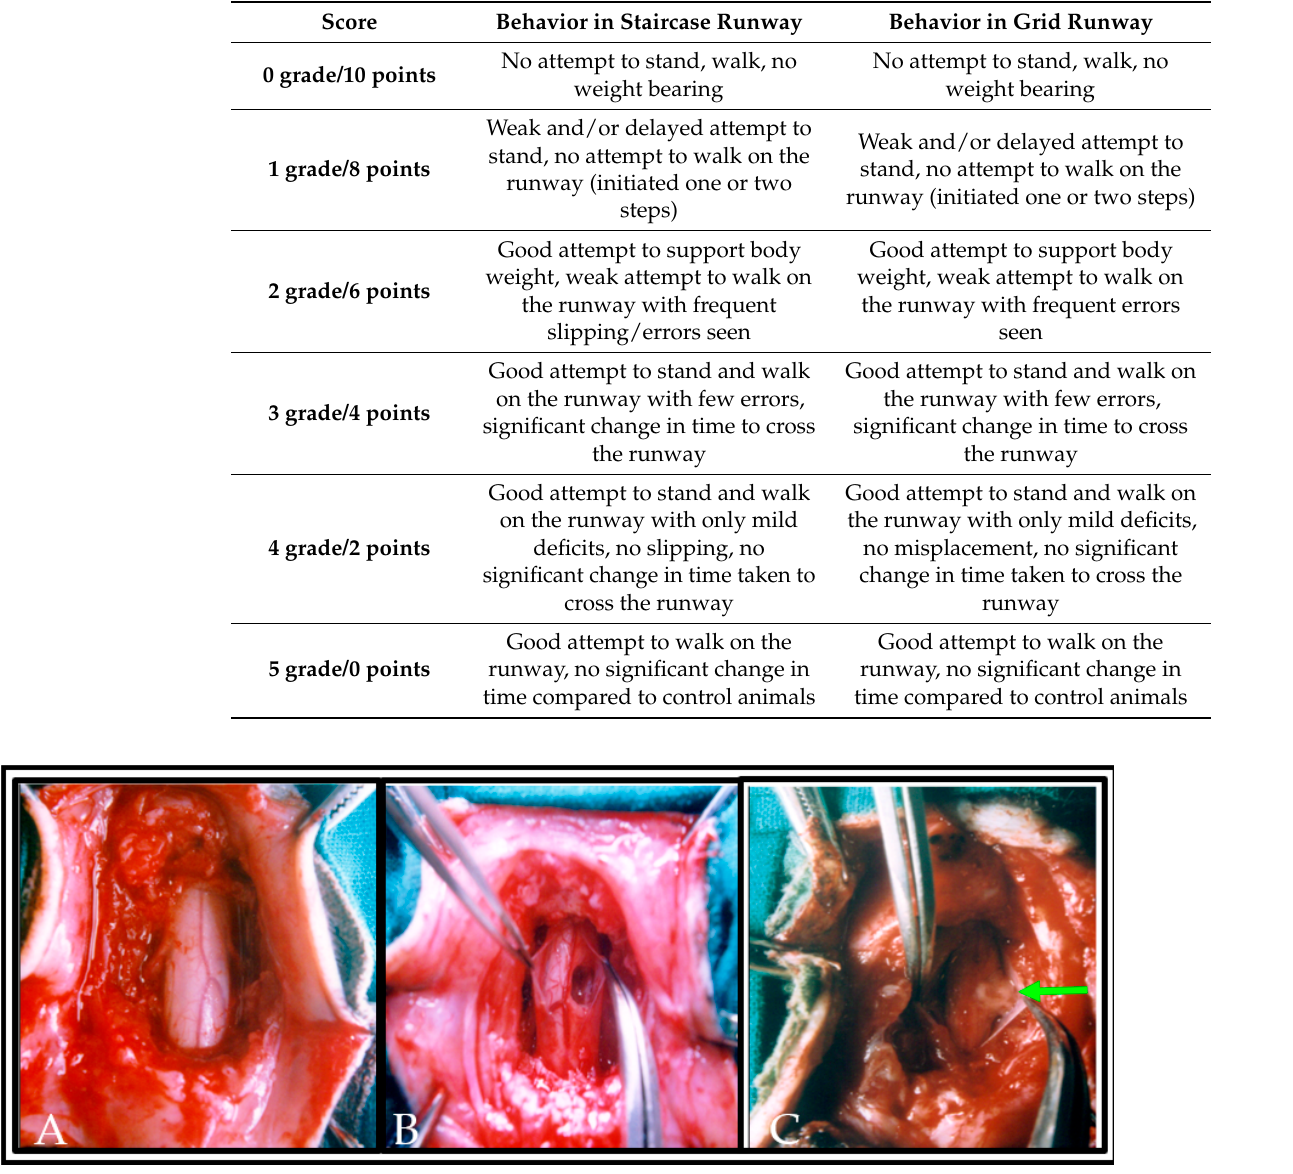
Figure 3. Photograph showing the completion of laminectomy and exposure of the dorsal and lateral surface of normal spinal cord segments in situ with intact meningeal coverings, neighboring blood vessels and dorsal rootlets ( A ). In ( B ), the dura was slit and a hemisection lesion cavity (approximately 5 mm) was created unilaterally. Care has been taken to not disrupt the neighboring blood vessels in the left side of spinal cord or along the dorsal nerve rootlets. In ( C ), the hemisected lesion cavity was filled with the donor tissue and plasma clot obtained from the same animal. An arrow indicates the transplanted tissue in lesioned cavity of the spinal cord.